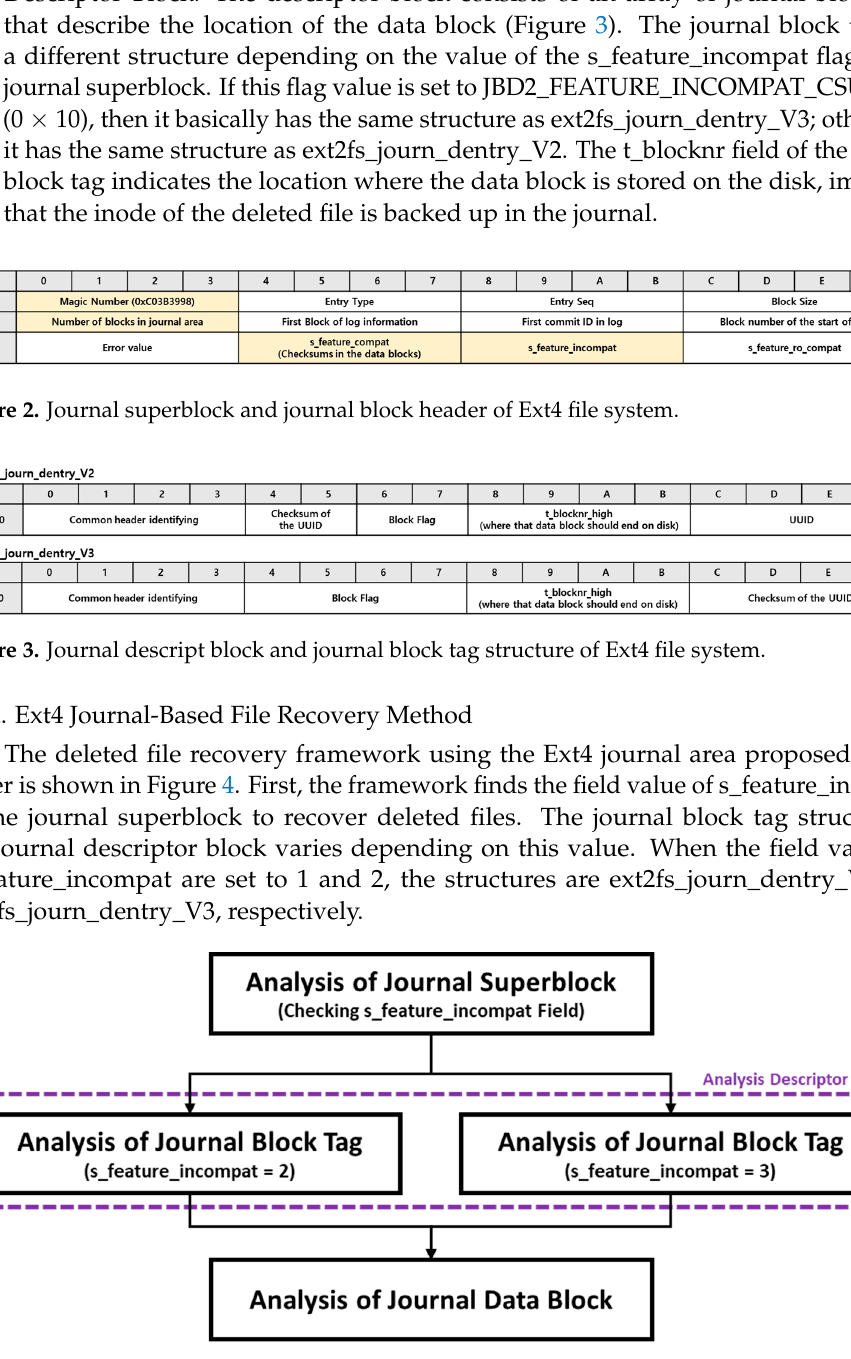
Figure 4. Ext4 journal-based file recovery module using TSK.